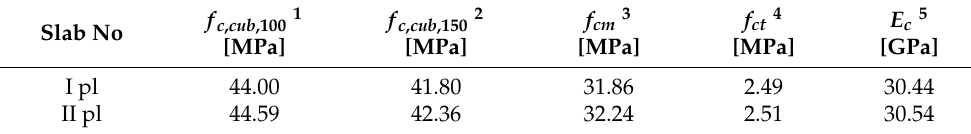
Figure 5. Determination of technical characteristics of the concrete and reinforcements. ( a ) Determi- nation of the compressive strength of concrete cubes, ( b ) tensile strength of reinforcements. Table 3. Concrete technical characteristics.